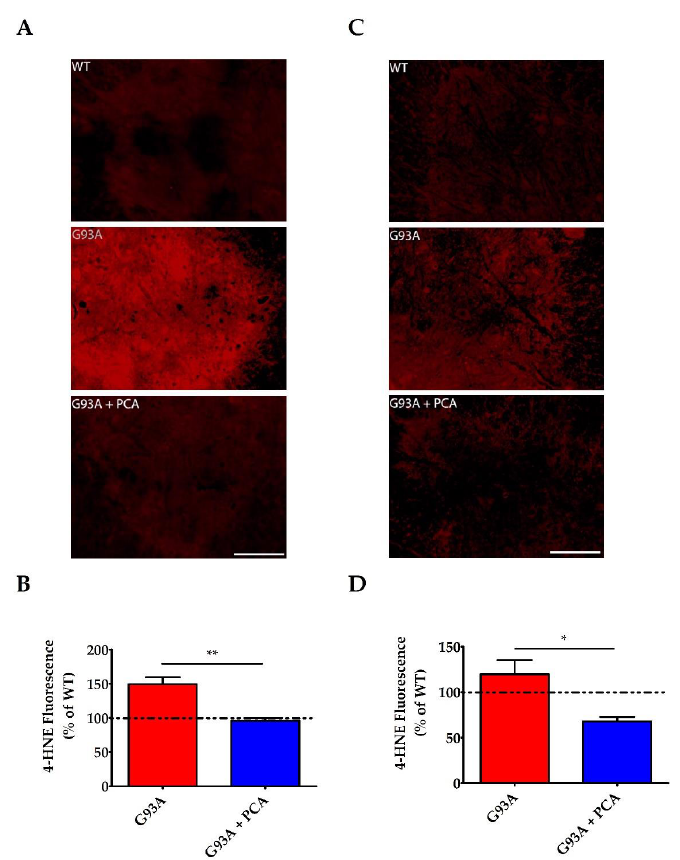
Figure 4. PCA treatment significantly reduces lipid peroxidation in the ventral horn of the spinal cord in the hSOD1 G93A mouse model of ALS. ( A , C ) Representative images of lumbar spinal cord ventral horns stained for 4-HNE from two littermate groups of wildtype control mice (WT), untreated hSOD1 G93A mice (G93A), and hSOD1 G93A mice treated orally with 100 mg/kg PCA beginning at disease onset (G93A+PCA). Mice were euthanized at 105 days of age and ventral horns were stained with an antibody to 4-HNE to measure lipid peroxidation. Scale bar = 70 μm. ( B ) Quantification of spinal cord ventral horns stained with 4-HNE as described and shown in A. The 4-HNE fluorescence intensity of untreated and PCA-treated hSOD1 G93A littermate mice were normalized and expressed as a percentage of mean 4-HNE fluorescence measured in the WT littermate control mouse. Data are expressed as the mean ± SEM; 6 ventral horns were imaged per mouse. ** indicates p < 0.01 compared to the untreated hSOD1 G93A control littermate (paired t -test). Raw mean 4-HNE fluorescence units for the untreated hSOD1 G93A mouse (11.70 ± 0.78) × 10 6 ) are significantly higher than the WT littermate mouse (7.83 ± 0.16) × 10 6 ) ( p < 0.01) ( D ) Quantification of spinal cord ventral horns stained with 4-HNE as described and shown in C. The 4-HNE fluorescence intensity of untreated and PCA-treated hSOD1 G93A littermate mice were normalized and expressed as a percentage of mean 4-HNE fluorescence measured in the WT littermate control mouse. Data are expressed as the mean ± SEM; 6 ventral horns were imaged per mouse. * indicates p < 0.05 compared to the untreated hSOD1 G93A control littermate (paired t -test). Raw mean 4-HNE fluorescence units for the untreated hSOD1 G93A mouse (6.56 ± 0.88) × 10 6 ) are significantly higher than the WT (4.17 ± 0.24) × 10 6 ) ( p <